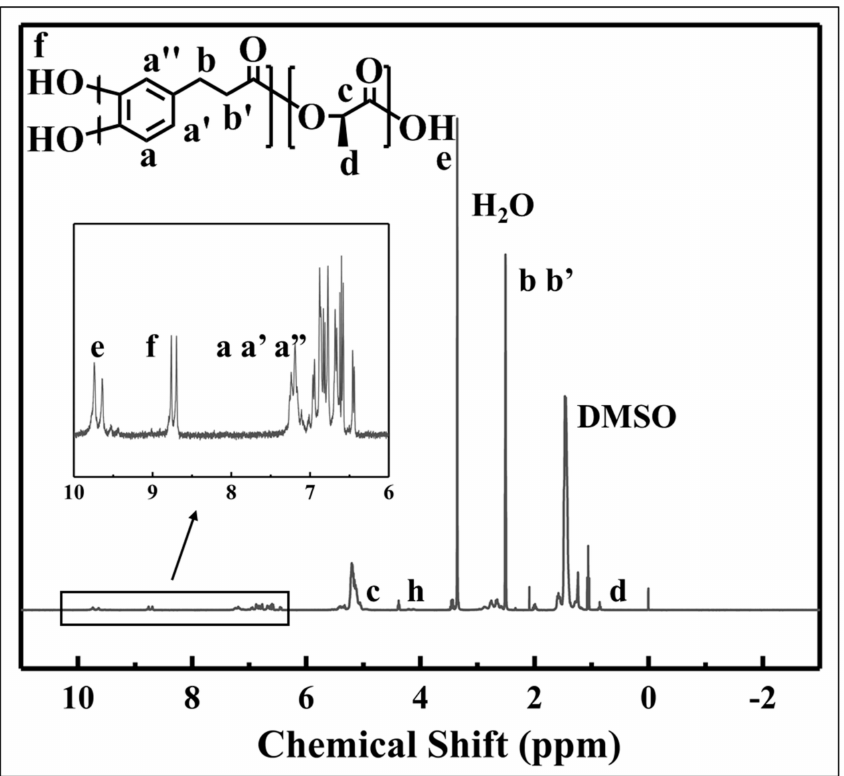
Figure 2. 1 H NMR spectra of poly(DHHCA- co -LA)